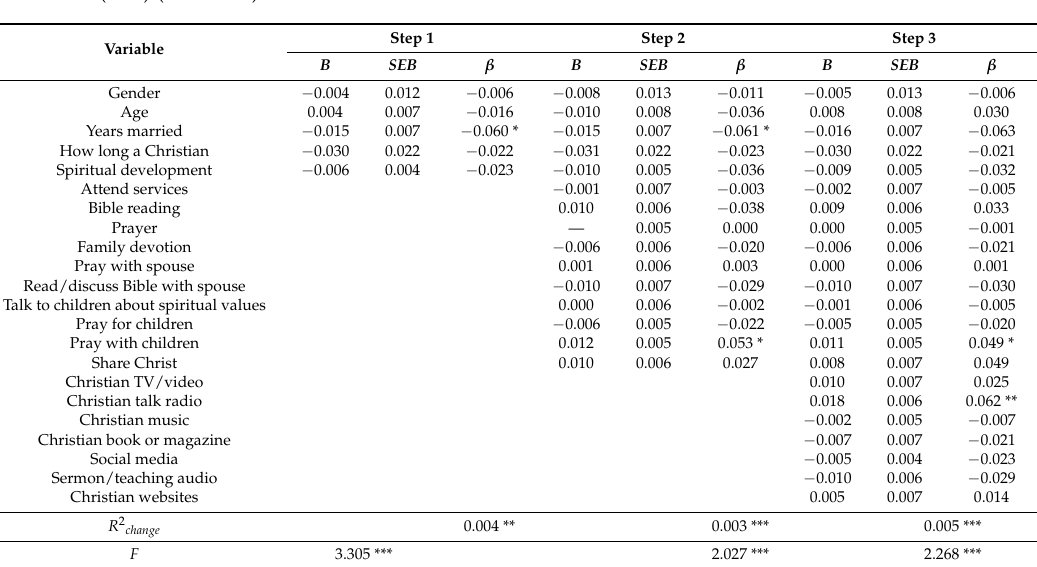
Table 5. A summary of the hierarchical regression analysis for the variables predicting intimate partner violence (IPV) ( N =